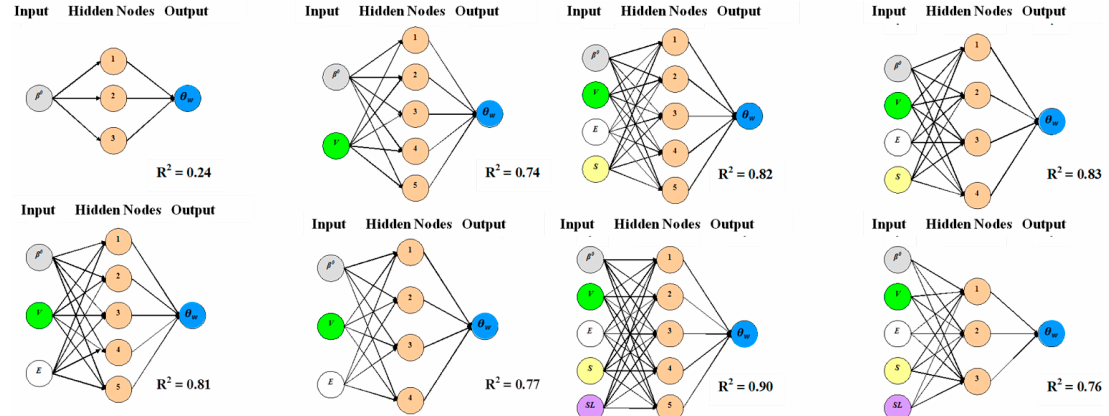
Figure 8. A multilayer perceptron with two hidden layers.